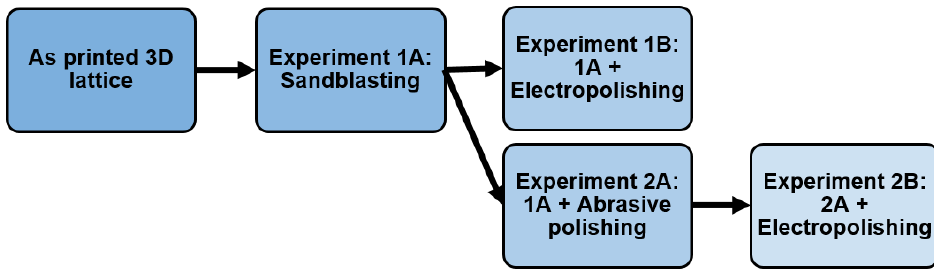
Figure 2. Sequence of post-processing techniques employed in the various experimental groups.